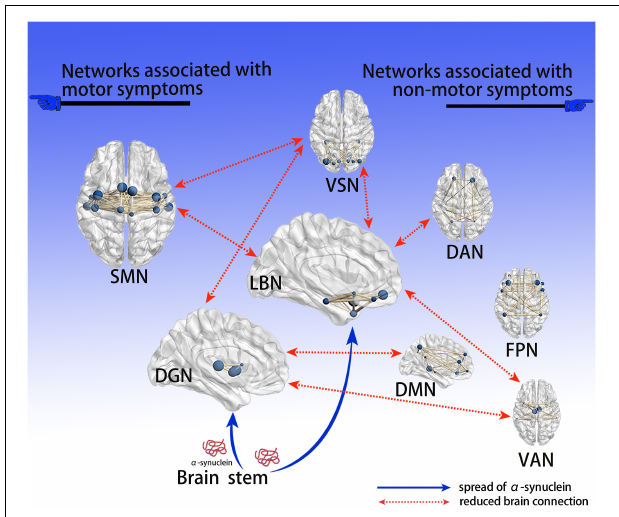
FIGURE 5 | Hypothetical model explaining how deposition of α -syn affects brain networks. Based on Braak’s PD α -syn propagation theory, since the deep gray matter and limbic systems are close to the brain stem, they are the first to be affected by α -syn; the abnormal brain network connections found are consistent with the propagation path of α -syn. Neurotoxic α -syn deposits in these 2 encephalic regions, affecting the function of neurons; the connection of related brain networks is then affected, resulting in a series of clinical PD symptoms. We believe that dysfunctional brain connections of the DGN and SMN are associated with motor symptoms, while the DMN, DAN, FPN, and VAN are associated with non-motor symptoms; notably, the LBN and VSN are associated with both motor and non-motor symptoms. PD, Parkinson’s disease; α -syn, α -synuclein; VSN, visual network; SMN, somatomotor network; DAN, dorsal attention network; VAN, ventral attention network; LBN, limbic network; FPN, frontoparietal network; DMN, default mode network; DGN, deep gray matter network.